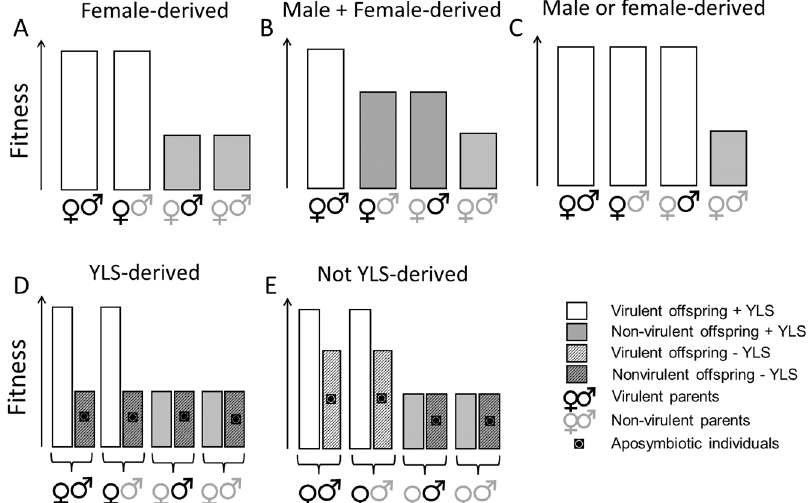
Figure 1. Study predictions based on the vertical transmission of endosymbionts through the egg and a possible role for YLS in virulence adaptation. If endosymbionts determine virulence, then the progeny of virulent females will also be virulent, irrespective of the male parent ( A ). If the virulent male parent also determines virulence, then progeny virulence will respond in an additive manner to having one or two virulent parents ( B ). If virulence is determined by either parent (i.e., in the case of a major resistance gene), then progeny with one or two virulent parents, of either sex, will be virulent ( C ). Where virulence is female-derived, the role of YLS and other vertically transmitted endosymbionts can be assessed by comparing aposymbiotic and symbiotic planthoppers. Where the relative fitness of progeny with virulent or avirulent female parents is affected by removing endosymbionts (aposymbiotic), then the symbionts play a role in virulence adaptation ( D ). Where relative fitness patterns are maintained despite planthoppers being aposymbiotic, then the endosymbionts play little role in virulence adaptation ( E ).